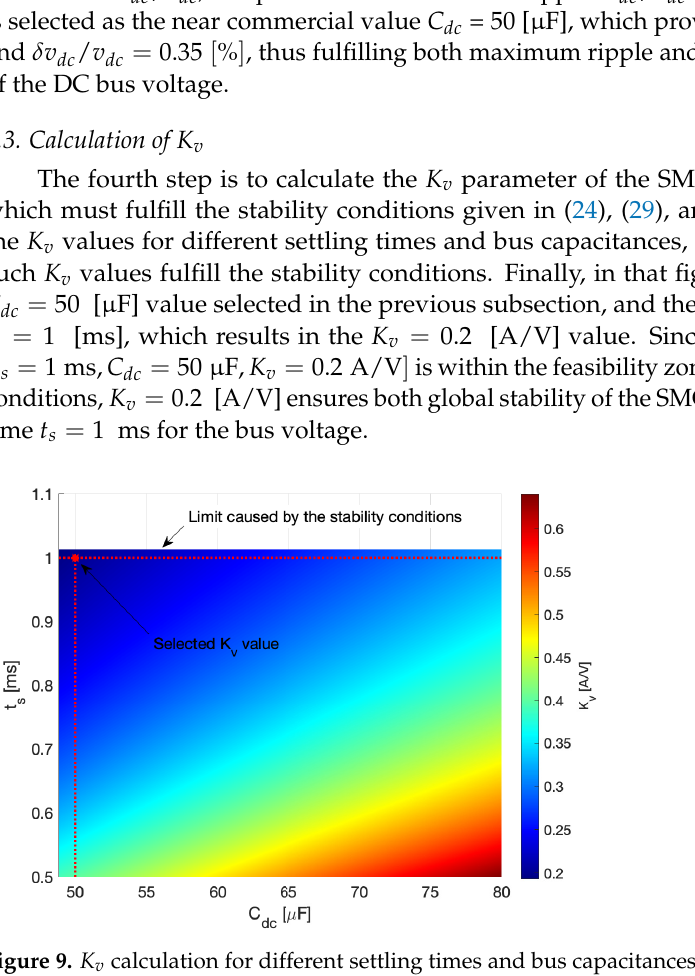
Figure 9. K v calculation for different settling times and bus